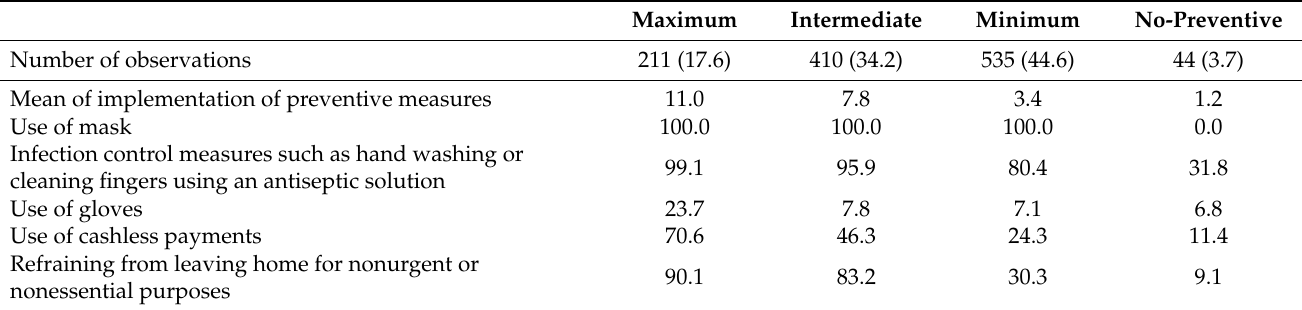
Table 6. Ratio of the implementation of preventive